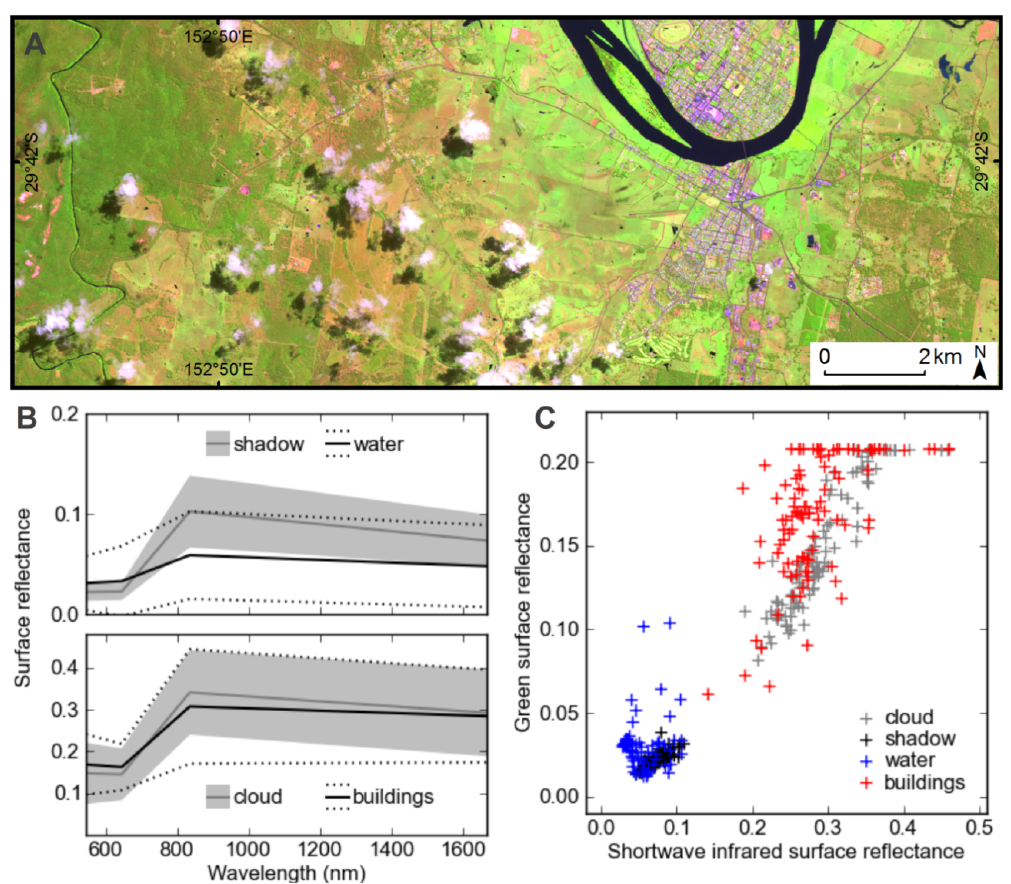
Figure 2. An example of the reflectance properties of selected pixels from a subset of image 8, showing the similarity of cloud to buildings, and cloud-shadow to water. ( A ) Image subset displayed with bands 4, 3, and 1 and red, green and blue; ( B ) Each spectral curve represents the mean ± two standard deviations of 100 manually sampled pixels; ( C ) A 2-dimensional scatterplot of the same 100 pixels, which were taken from the image